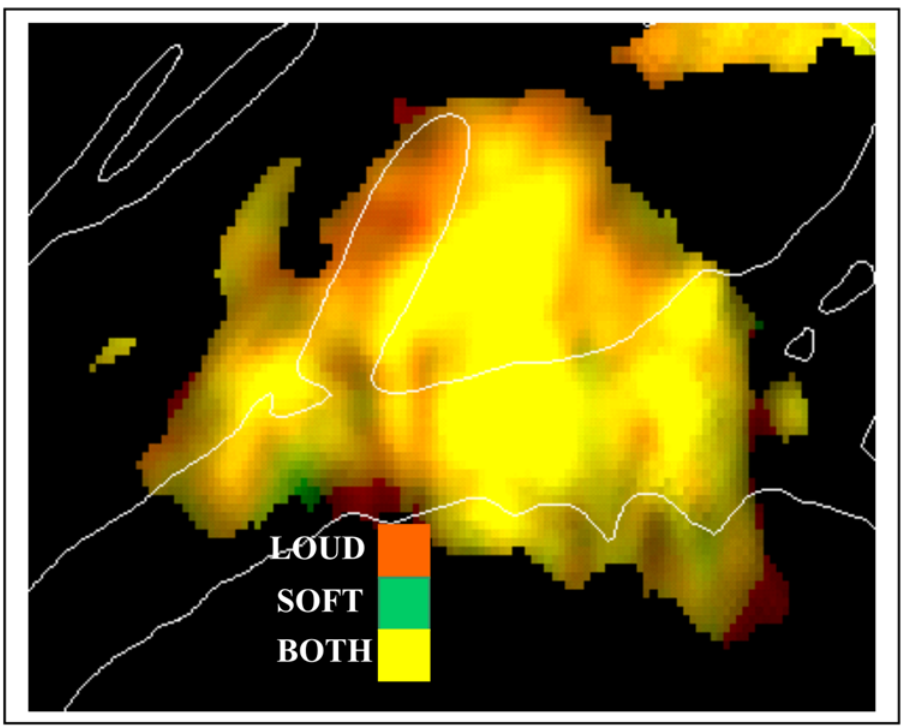
Figure 8. Effects of tone intensity. Significant activations (z-score range 5.0–20.0) are shown with the degree of saturation reflecting the magnitude of z-score, and the color showing relative magnitude of activation for different sound intensities: Red=intense, green=soft yellow=both. Data were averaged over subjects, spatial positions, attention, frequencies, image acquisition, and hemispheres.